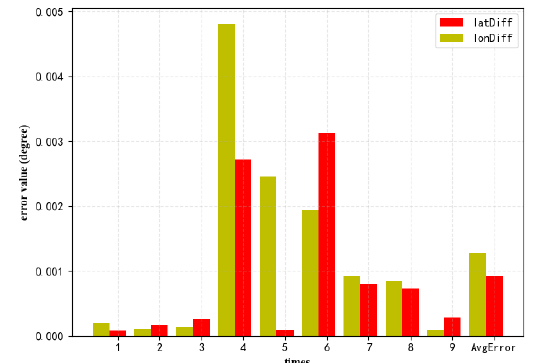
Figure 8. Geolocation difference comparison ( The upper figure shows the scatter difference of target geolocation data of 100m and 200m flight altitude, the under figure shows the difference of the estimate value and measurement value)